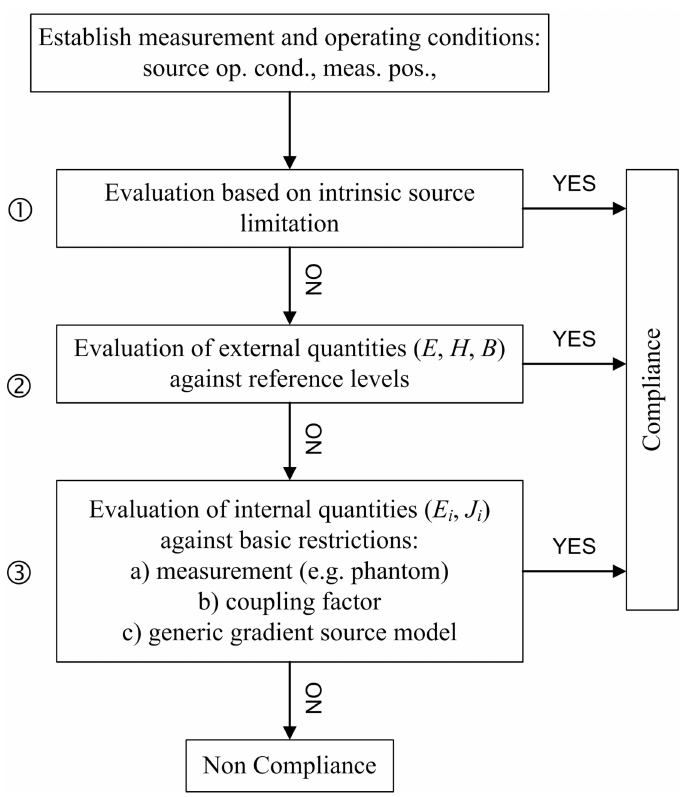
Figure 8. Assessment based on direct effects for the low frequency range (excluding specific absorp- tion rate,